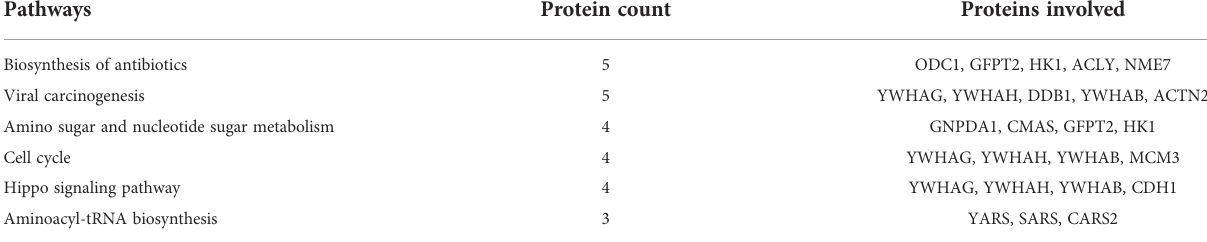
TABLE 2 Dysregulated pathways between equilibrated and cryopreserved spermatozoa and the associated proteins. Pathways